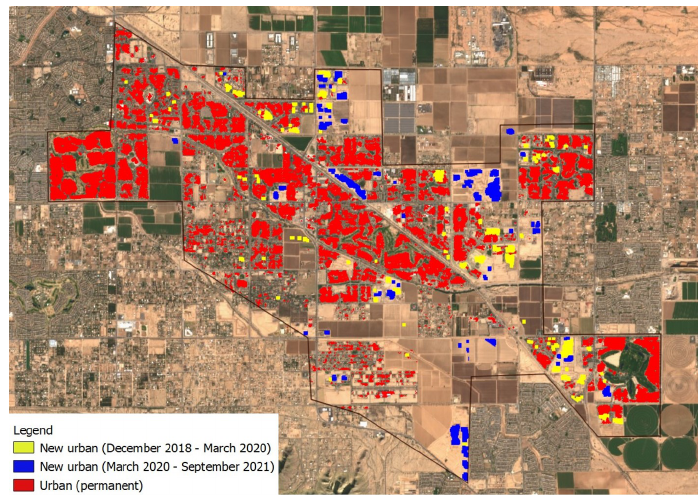
Figure 10. Sentinel-2 image and change detection results for Queen Creek: classes of Urban (perma- nent), New Urban 1 (2018–2020), and New Urban 2 (2020–2021) are shown for the area of interest within the black polygon.